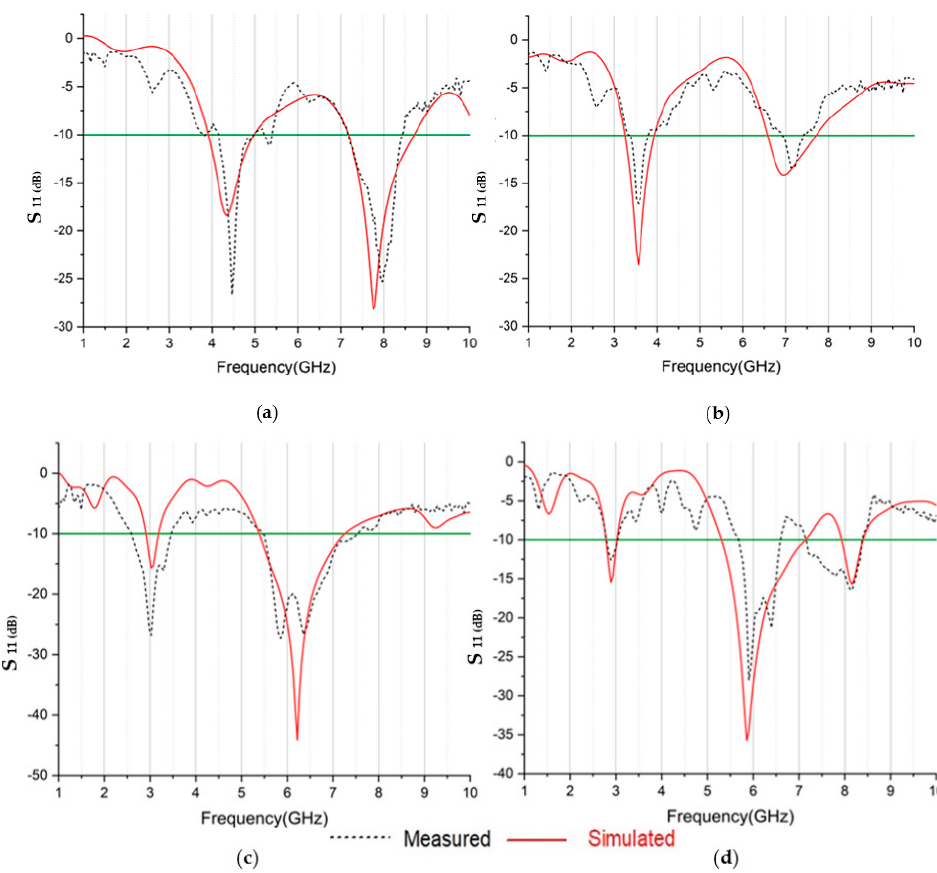
Figure 8. The simulated and measured S ‐ parameter occurs in all operational modes: ( a ) MODE 1, 4.36 and 7.78 GHz. ( b ) MODE 2, 3.56 and 6.89 GHz. ( c ) MODE 3, 3 and 6.2 GHz. ( d ) MODE 4, 2.88, 5.87, and 8.17 GHz.